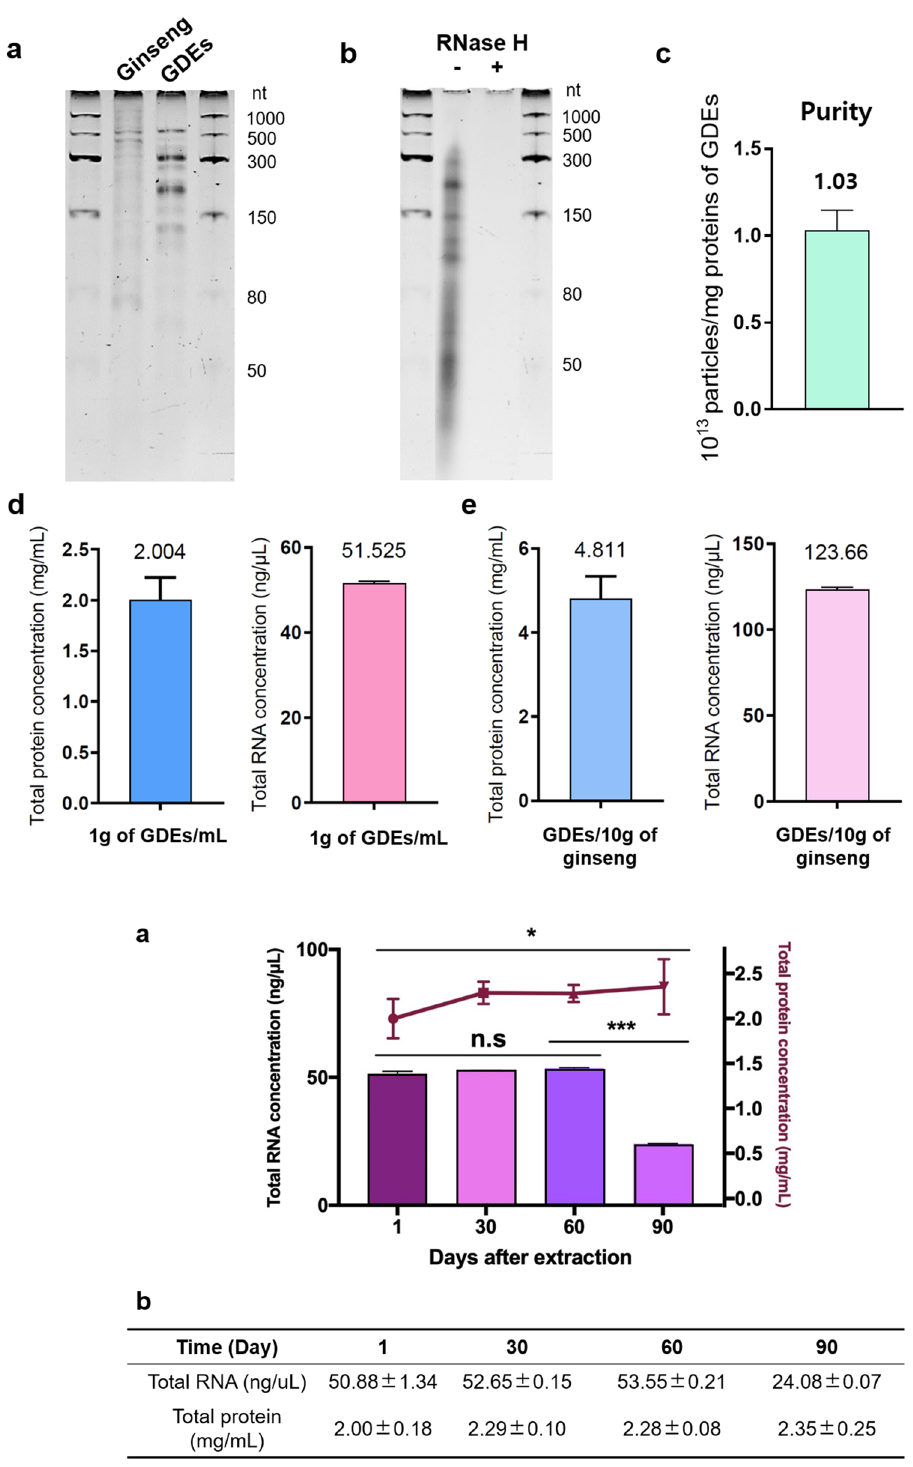
Fig. 7 Evaluation of GDE stabil- ity by measuring their total RNA and protein content for 90 days. a the total RNA and protein concentration of GDEs stored at room temperature measured for 90 days after isolation. b tabular form of the total RNA and protein concen- tration values in